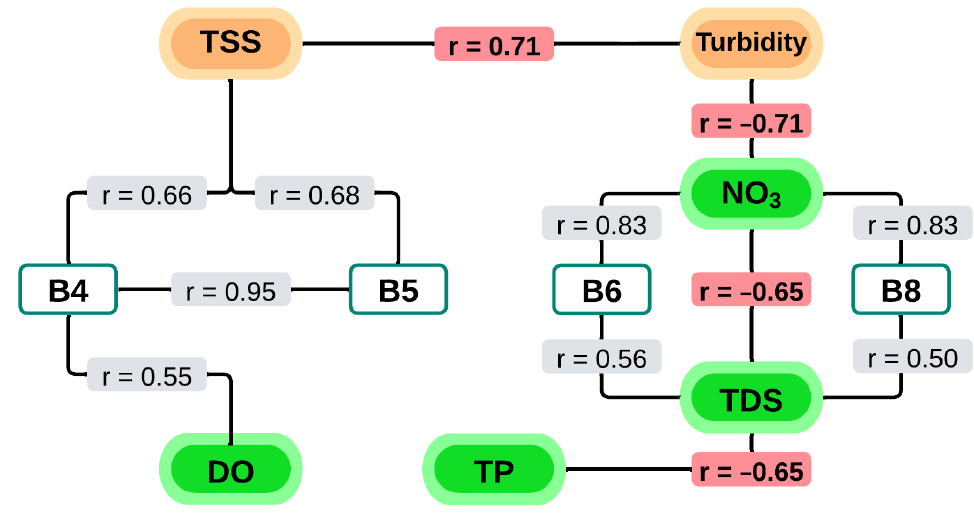
Figure 5. Relationship between analyzed water quality parameters and Sentinel-2A image bands. For the TDS-NO 3 correlation, bands B6 and B8 were directly related to each parame- ter in the empirical models. Therefore, with the correlations and empirical models, it is inferred that TSS and Turbidity concentrations, as optically active parameters [79,80], pre- sent indirect relationships through the Sentinel 2 image bands, with parameters difficult to extract spectral characteristics such as DO, NO 3 , TDS, and TP [81,82]. bands, with R 2 = 0.948 and RMSE = 0.182 mg/L (Table 2). The authors of [83] show that